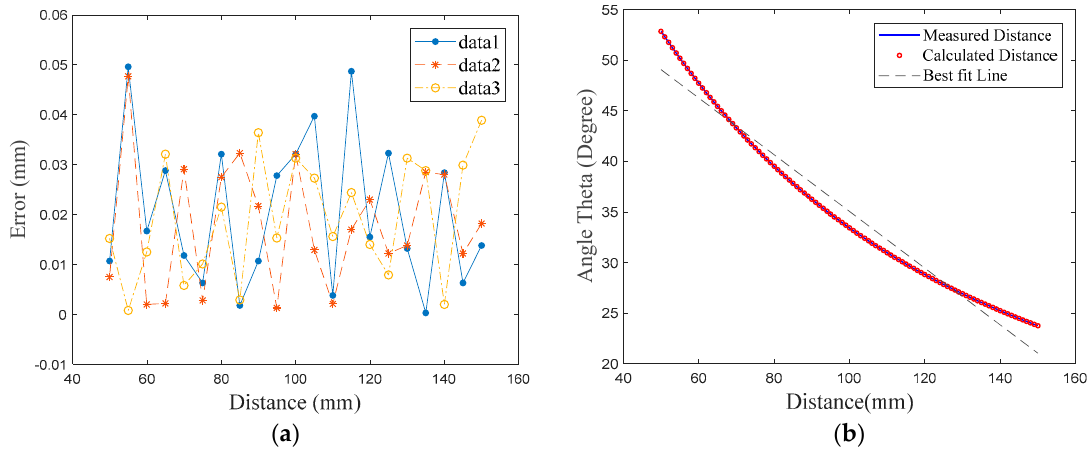
Figure 10. ( a ) Non-linearity result using three data of the calculated distance; ( b ) Non-linearity results compared with the measured distance, calculated distance and best fit line.